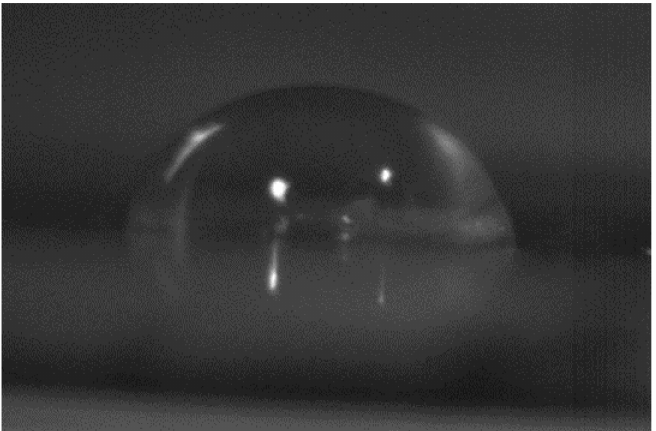
Figure 5. Contact angle measurement of